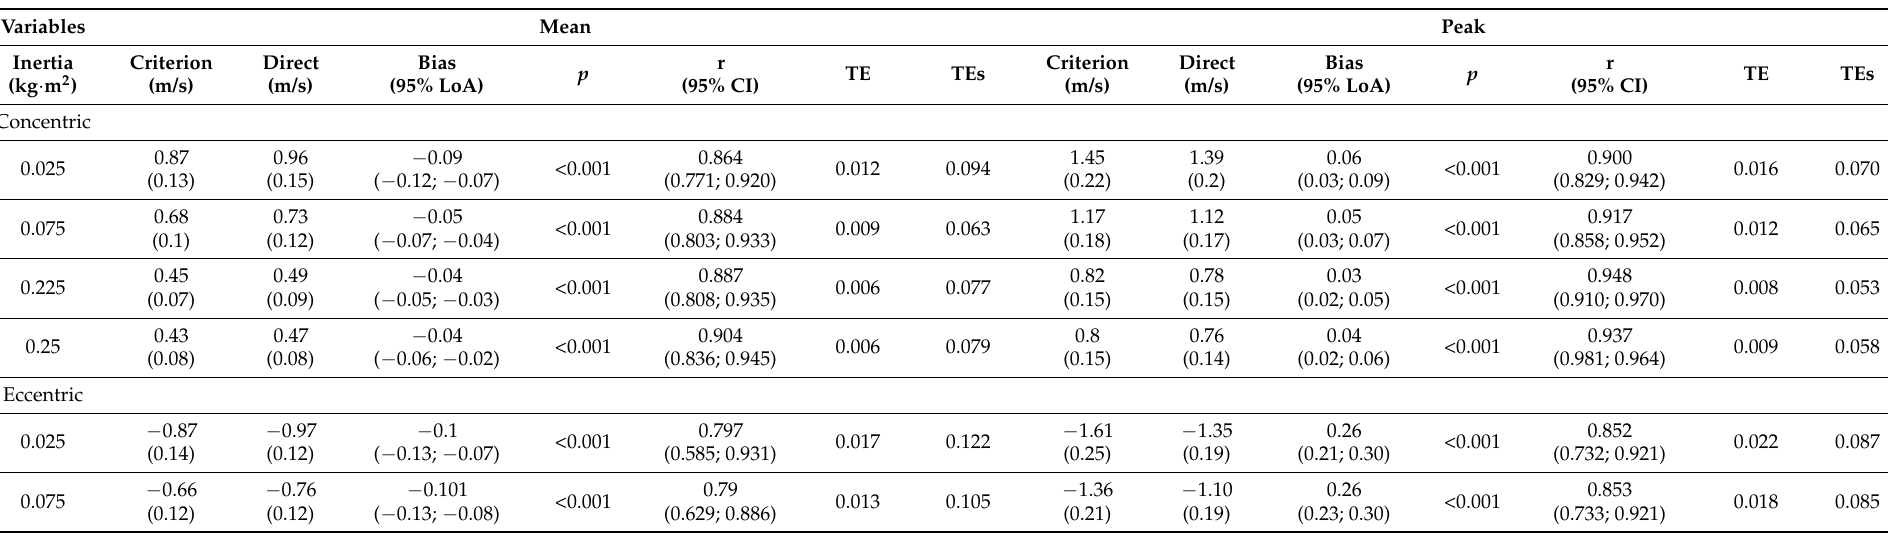
Table 3. Agreement of velocity values between criterion (linear encoder) and direct measures (rotary